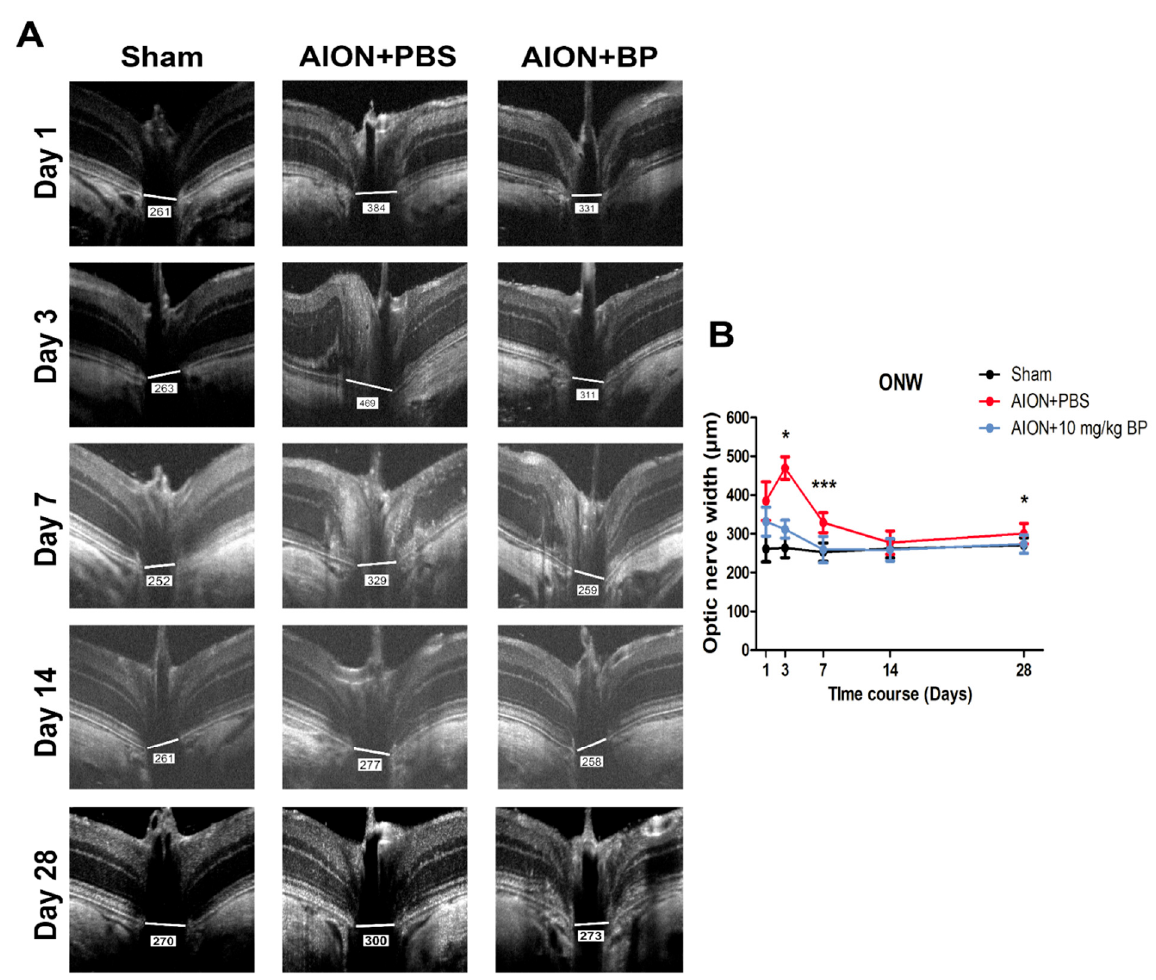
Figure 3. Imaging of optic nerve width by OCT scanning. OCT images of ONW in each group on days 1, 3, 7, 14, and 28 ( A ). The BP-treated group exhibited significantly alleviated optic disc edema on days 3, 7, and 28 compared with the PBS-treated group. (311.95 ± 23.21 μ m versus 469.58 ± 29.35 μ m, 259.35 ± 33.73 μ m versus 329 ± 25.73 μ m, and 273.71 ± 23.22 μ m versus 300.73 ± 26.41 μ m, respectively) ( B ). (***, p ≤ 0.001; *, p ≤ 0.05; n = 6.)